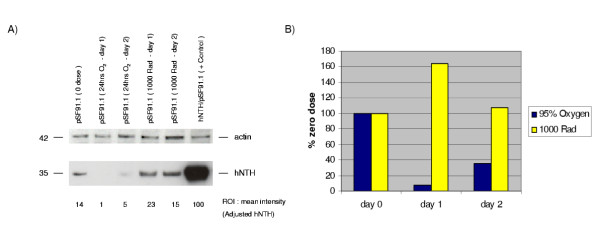
Western analysis of endogenous hNTH repair gene after exposure to O2 and IR. (A) Analysis of hNTH expression in A549 vector control cells following O2 or IR treatment. The ROI band mass mean intensity was calculated for individual bands and hNTH expression was normalized to the corresponding actin loading control. (B) Graph of ROI band mass normalized to the pSF91.1 zero dose.